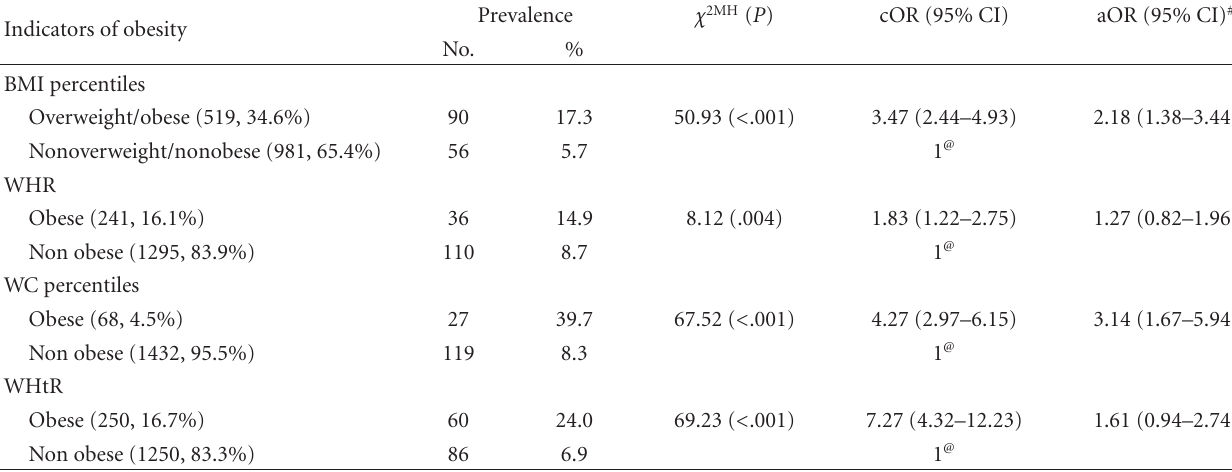
Table 2: Prevalence of elevated blood pressure among study sample of school adolescents in relation to di ff erent types of obesity. Indicators of obesity